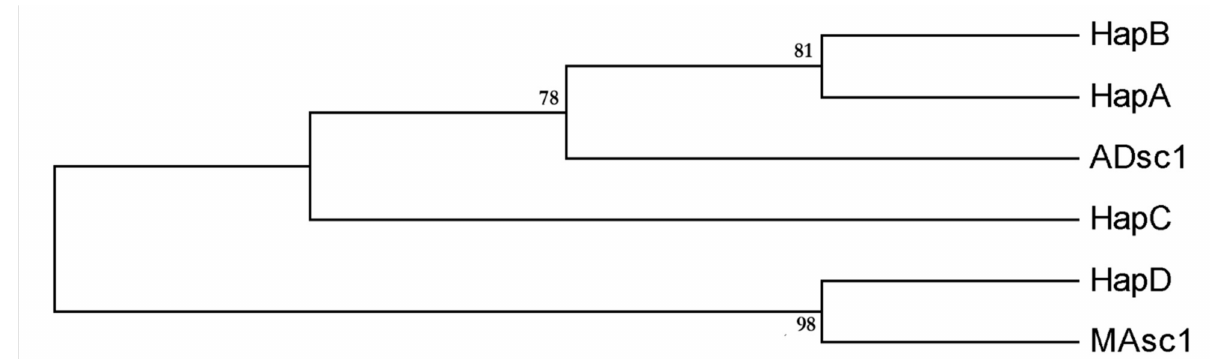
Figure 2. Maximum-likelihood consensus dendrogram depicting the genetic relationships among the four haplotypes observed in the current study, along with one marmoratus and one Adriatic sequence, obtained from GenBank. Bootstrap values greater than 60% are shown on the